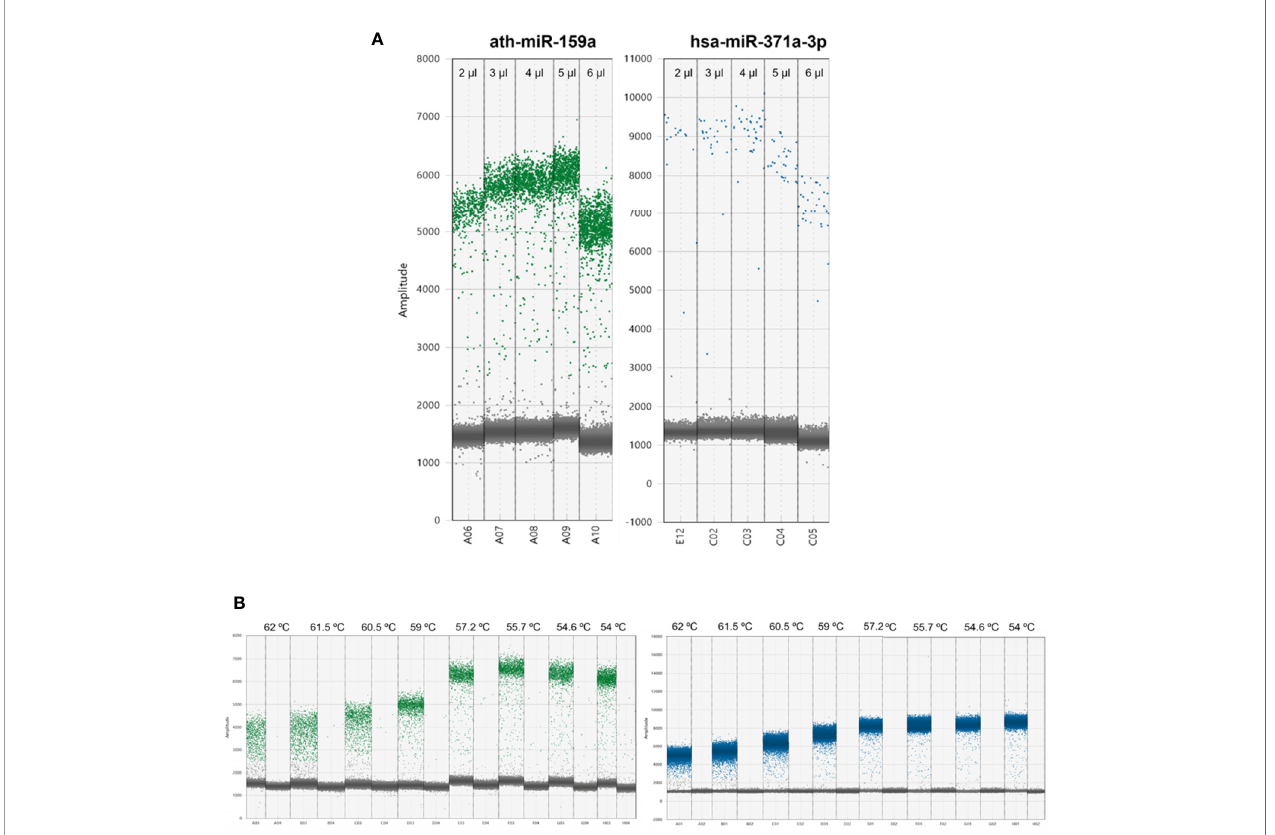
FIGURE 2 | (A) Optimization of DigiMir pipeline. Ath-miR-159a and hsa-miR-371a-3p input optimization. (B) Temperature gradient for further optimization of ath-miR-159a (green) and hsa-miR-371a-3p (blue) assays on the DigiMir pipeline. Notice that the best separation is achieved approximately 56°C for both